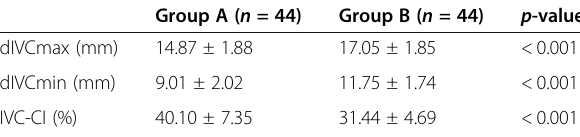
Table 5 Comparison of IVC measurement values between the two study groups